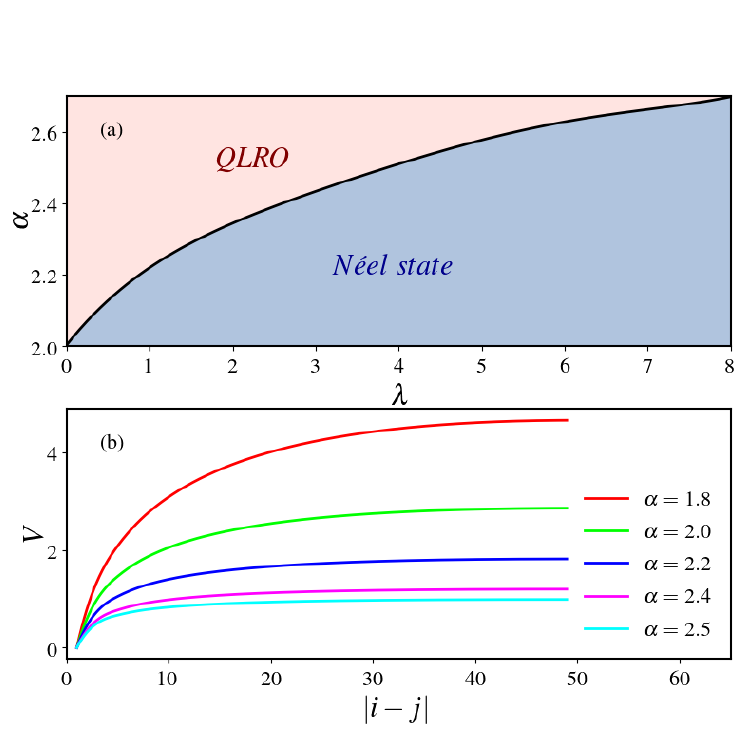
Figure 1: (a) Phase diagram of the Heisenberg chain with long range staggered in- teractions reproduced from Ref. [ 24 ] , as a function of the coefficient λ and exponent α ; (b) confining potential as a function of α for λ =